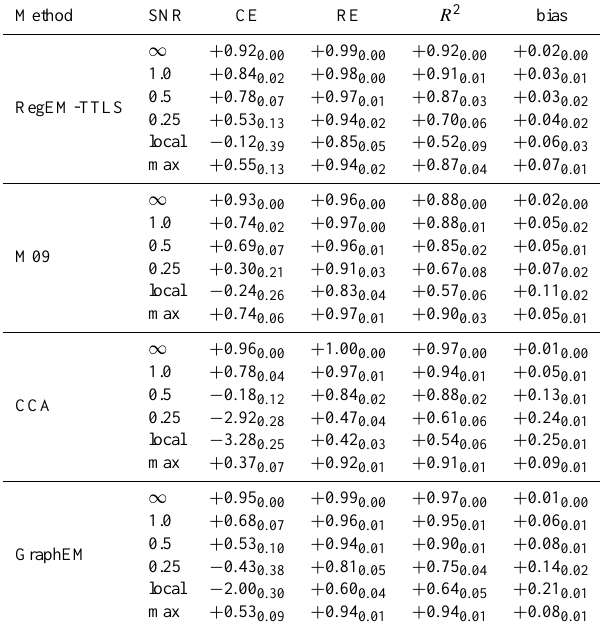
Table 2. Verification statistics summary for the global mean tem- perature time series, using the staircase network. CE, RE, R 2 and bias are computed for the low-frequency component (20yr low- pass) of the reconstructed global mean. All numbers given outside of parentheses are the mean of the 100-member ensemble; numbers in parentheses are the corresponding standard